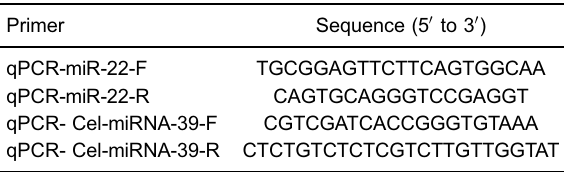
Table 1. Primer sequences for quantitative real time polymerase chain reaction reverse